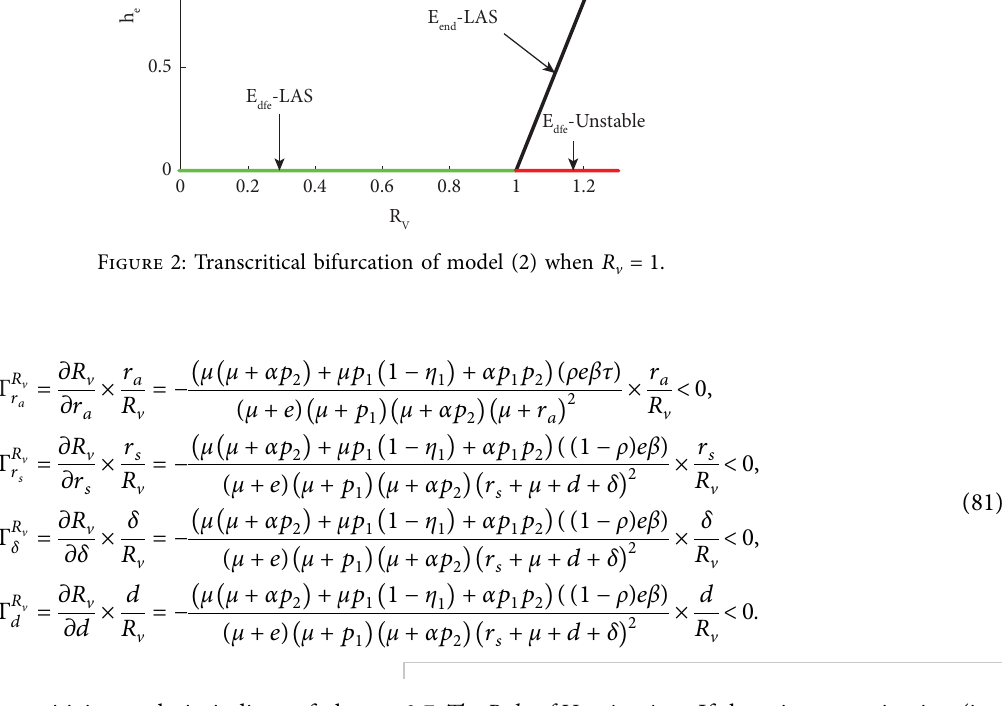
From Table 1, the sensitivity indices with negative signs indicate that the value of R v decreases when the parameter values are increased and the value of R v increases when the parameter values are decreased, while sensitivity indices with positive signs indicate that the value of R v increases when the parameter values are increased and the value of R v decreases when the parameter values are decreased.